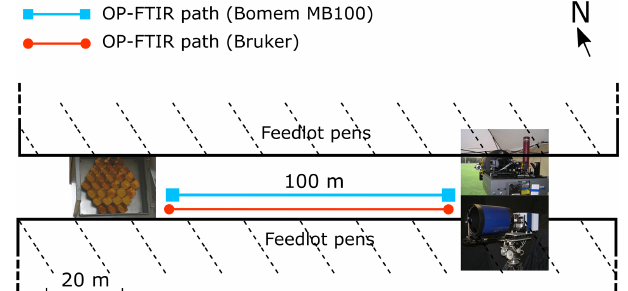
Figure 4. Two OP-FTIR spectrometers (Bomem MB100 and Bruker) during side-by-side operation in a commercial feedlot in Victoria in February